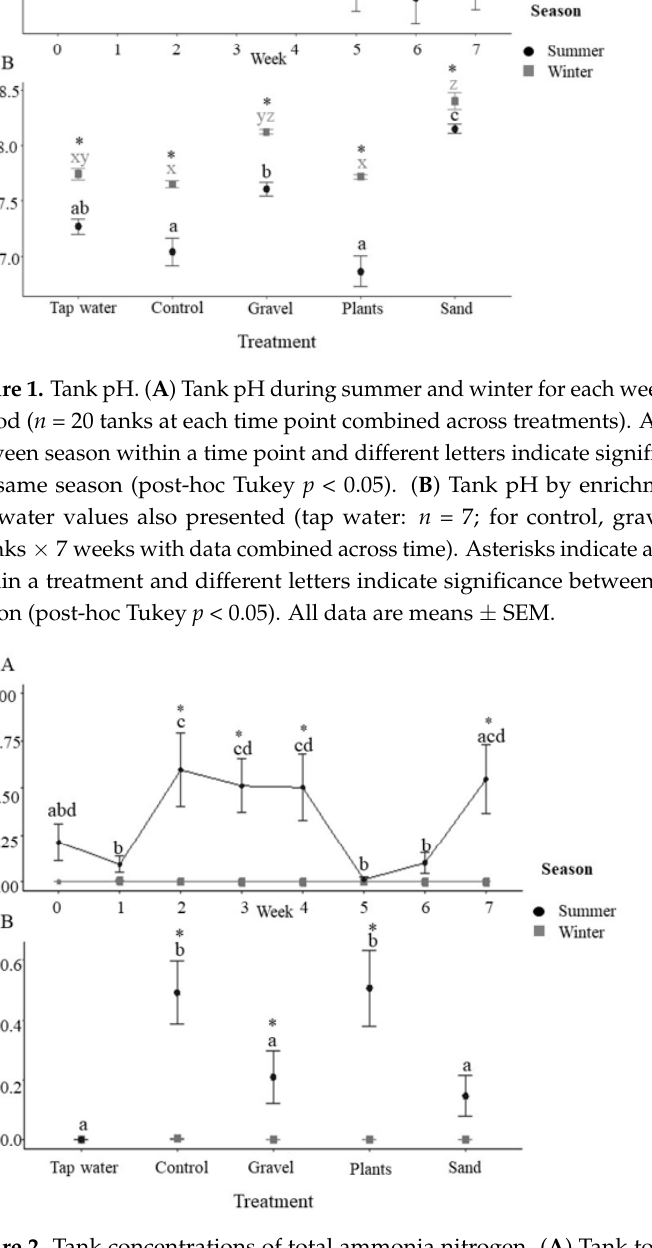
Figure 2. Tank concentrations of total ammonia nitrogen. ( A ) Tank total ammonia nitrogen (TAN; ppm) during summer and winter for each week of the 7-week experimental period ( n = 20 tanks at each time point combined across treatments). Asterisks indicate significance between season within a time point and different letters indicate significance between weeks within the same season (post-hoc Tukey p < 0.05). ( B ) Tank TAN (ppm) by enrichment method with incoming tap water values also presented (tap water: n = 7; for control, gravel, plants, sand, n = 35 i.e., 5 tanks × 7 weeks with data combined across time). Asterisks indicate significance between seasons within a treatment and different letters indicate significance between treatments within the same season (post-hoc Tukey p < 0.05). All data are means ± SEM.